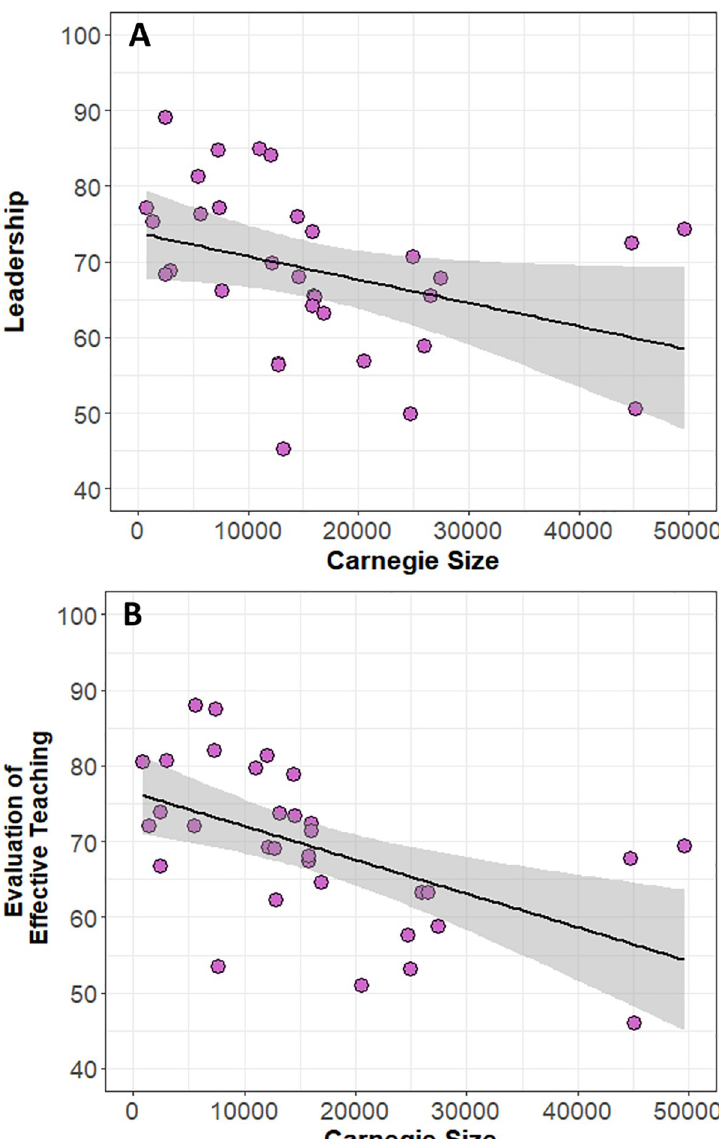
Fig 4. Linear regression for institution size by SCII: Leadership (A; P = 0.044, r 2 = 0.1) and SCII: Evaluation of effective teaching (B; P = 0.001, r 2 = 0.27). The gray band represents the 95% confidence interval (N = 32